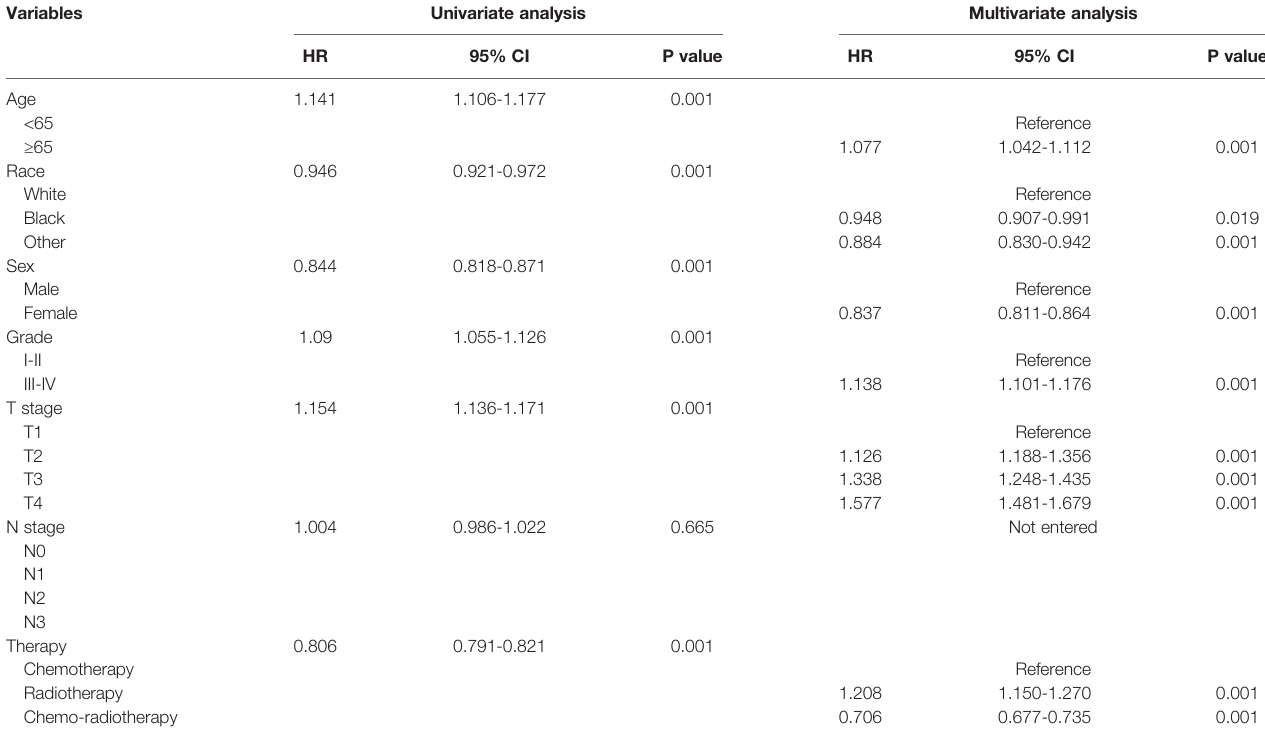
TABLE 2 | Univariate and multivariate analysis for